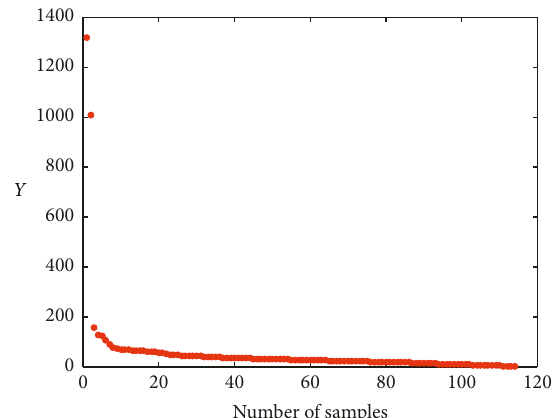
Figure 10: c i of each wood sample calculated and sorted in descending order.